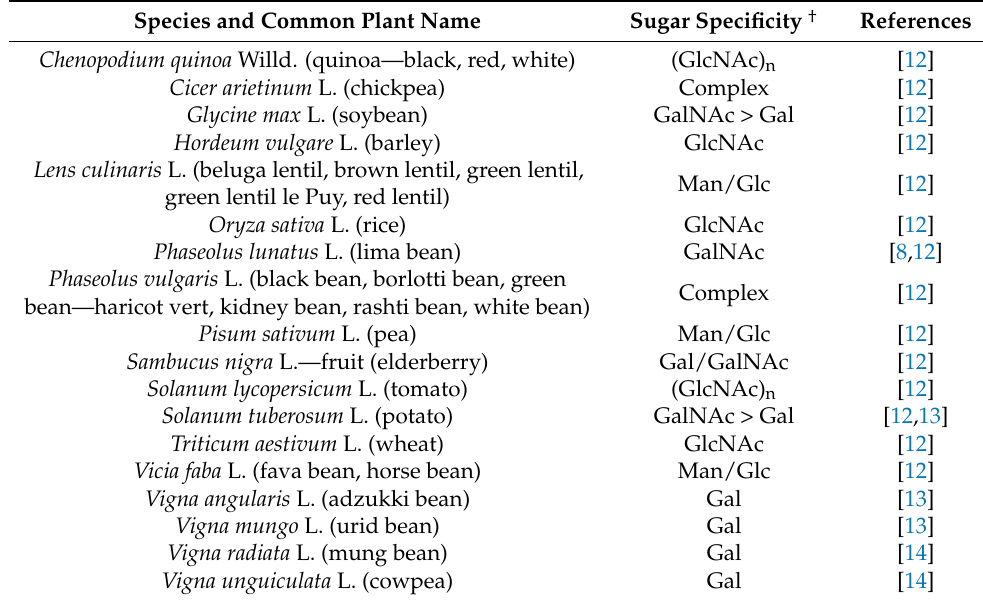
Table 1. Sugar specificity of lectins from selected plant